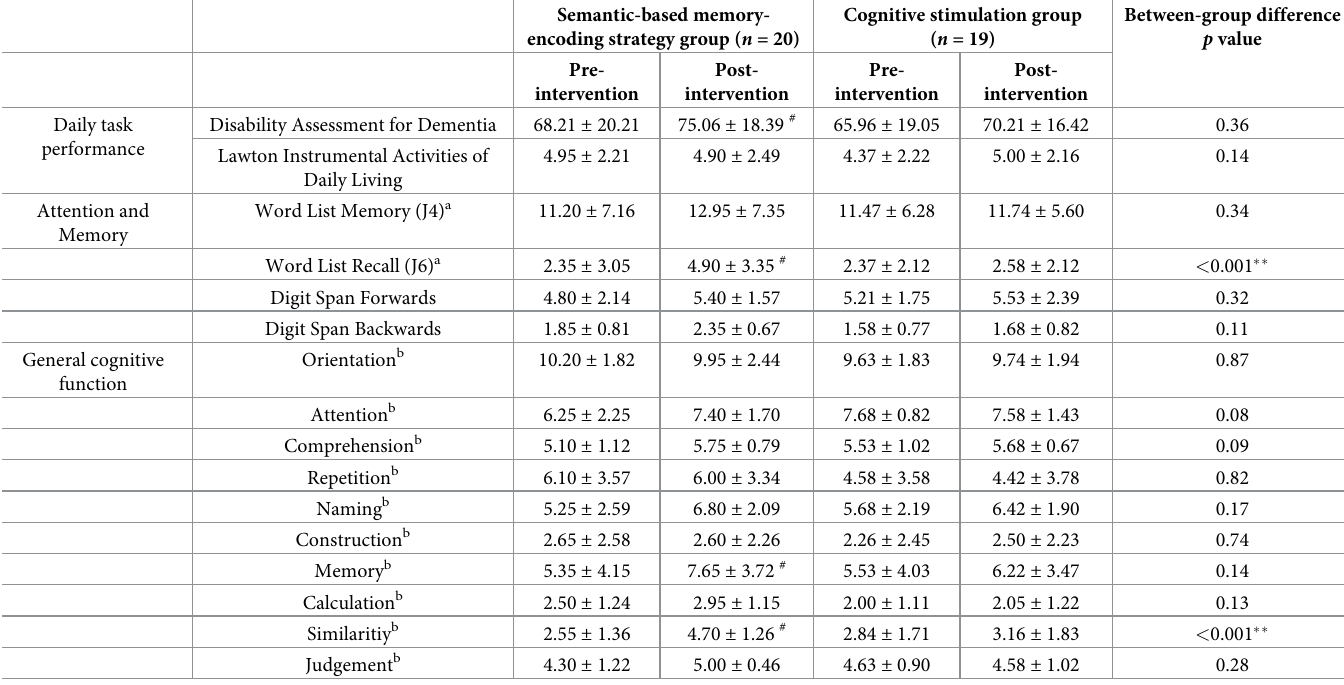
Table 2. Pre- and post-intervention